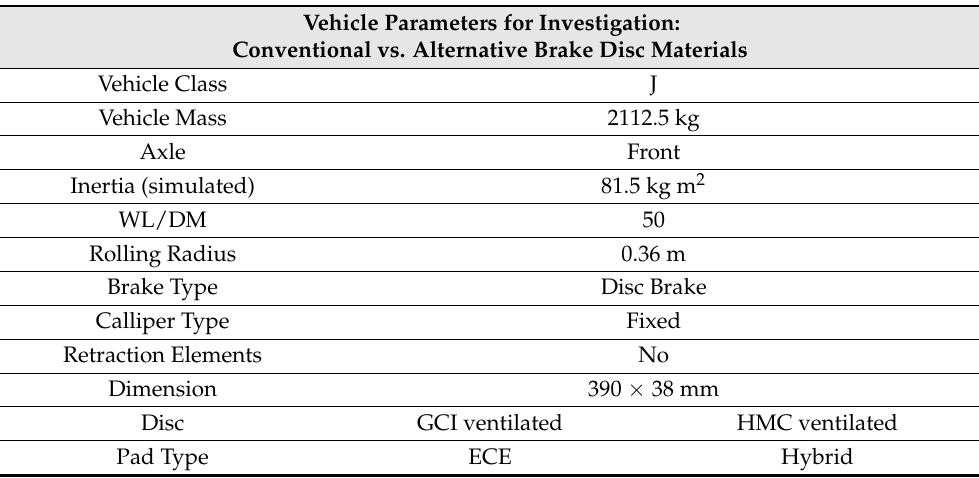
Table 3. Vehicle parameters for investigation: conventional vs. alternative friction materials. Vehicle Parameters for